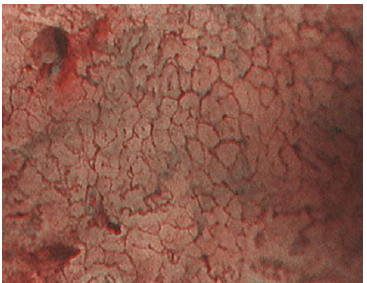
Figure 7. The mesh pattern suggests tubular adenocarcinomas.